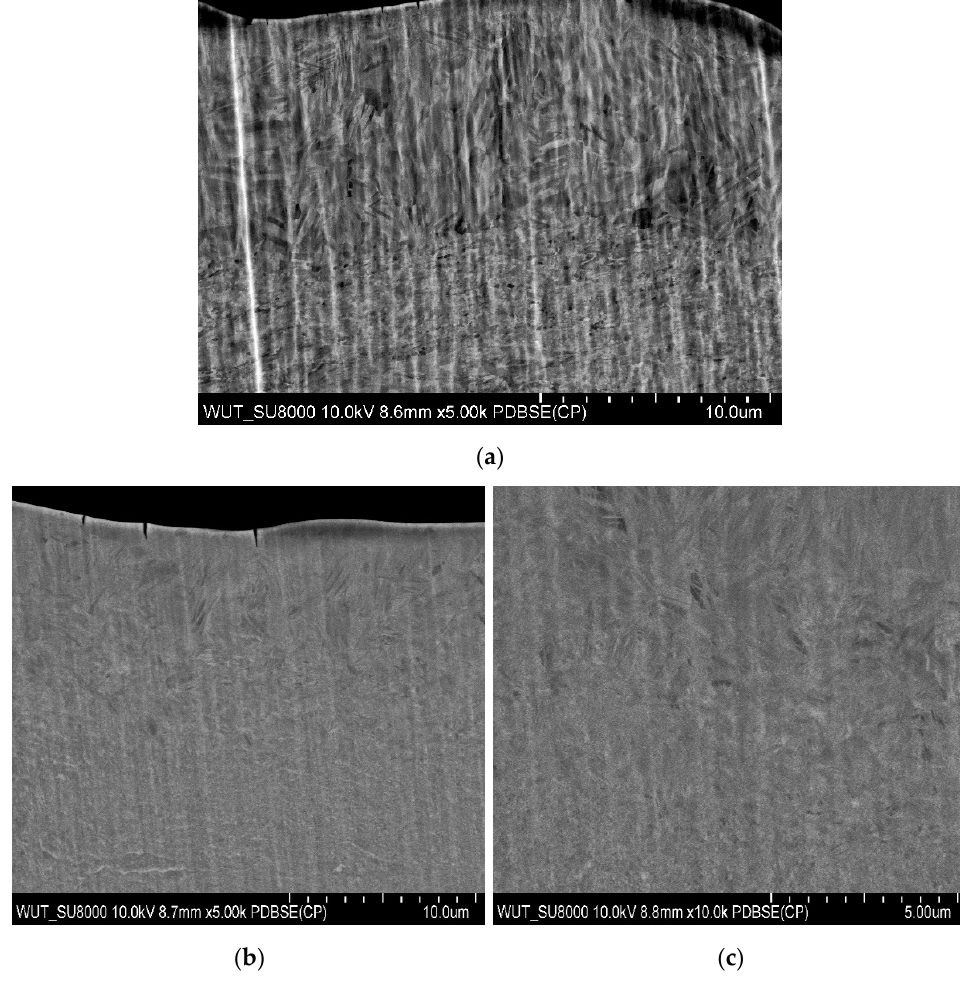
Figure 8. SEM cross-sectional images of laser-modified samples after 14 days for ( a ) CP-Ti N20 sam- ple, ( b ) Ti64 N20 sample (low magnification) and ( c ) Ti64 N20 sample (high magnification). sample, ( b ) Ti64 N20 sample (low magnification) and ( c ) Ti64 N20 sample (high